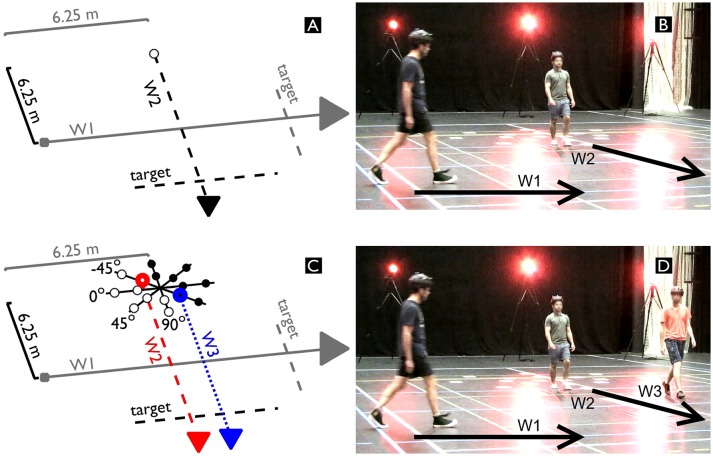
Schematic displays (A, C) and photos (B, D) of a dyadic (A, B) and triadic (C, D) trial during which each participant had to reach the target line on the other side of the interaction area. Walker 1 (W1) always started at 6.25 m from the center of the interaction area. In the dyadic trials, Walker 2 (W2) also started at 6.25 m. In the triadic trials, the center of W2 and Walker 3 (W3) was set at 6.25 m. The formation of W2 and W3 was angled at −45°, 0°, 45°, or 90°, with a diameter of 2 or 4 m. The participants provided written informed consent for the publication of these images.